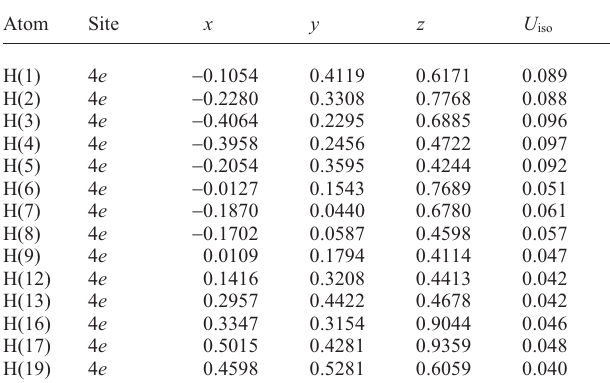
Table 2. Atomic coordinates and displacement parameters (in Å 2 )